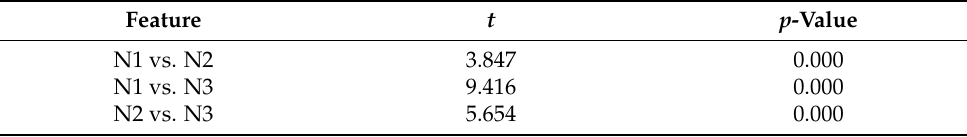
Table 6. t-test under di ff erent nitrogen treatments.